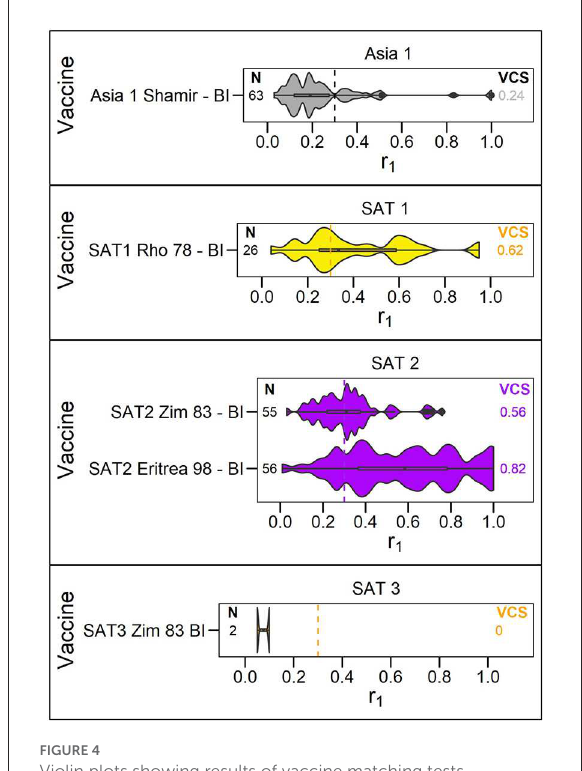
FIGURE4 Violin plots showing results of vaccine matching tests performed at the WRLFMD between 2011 and 2021, for each vaccine/lineage combination for serotypes Asia 1, and SAT 1–3. Resulting vaccine coverage scores are labeled on the right, and the number of tests performed are labeled on the left in black. Gray dashed line shows the cut off of 0.3 r 1 indicative of an effective vaccine